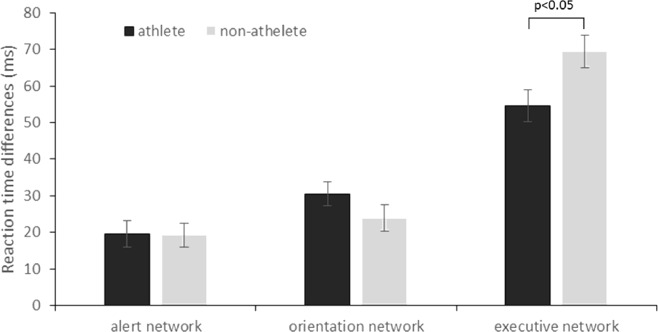
Reaction time differences that reflect the efficiency of the three attentional networks of athlete and non-athlete group (mean ± SE).The smaller differences on executive network and the larger differences on alerting and orientation network indicate a better function.